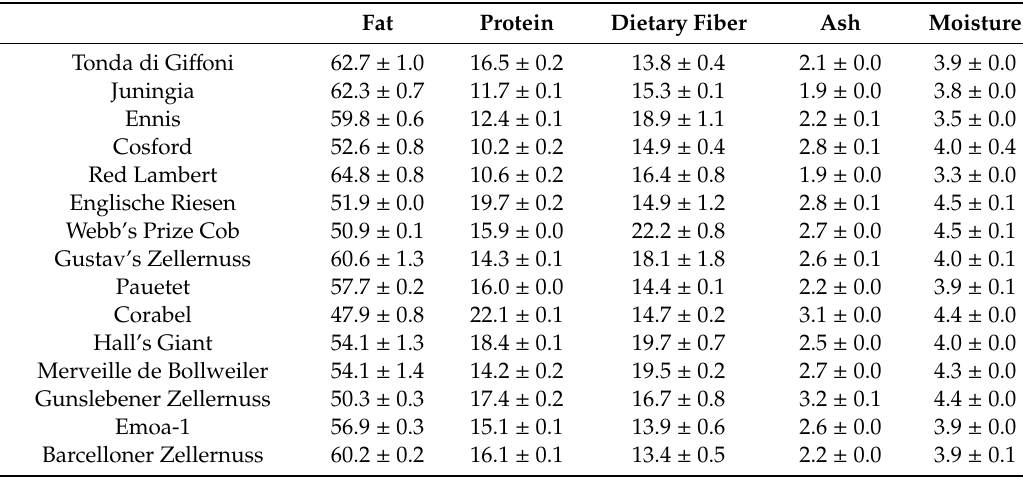
Table 1. Composition [g / 100 g] of 15 hazelnut cultivars grown under identical conditions in Thuringia, Germany. Fat Protein Dietary Fiber Ash Moisture Tonda di Gi ff